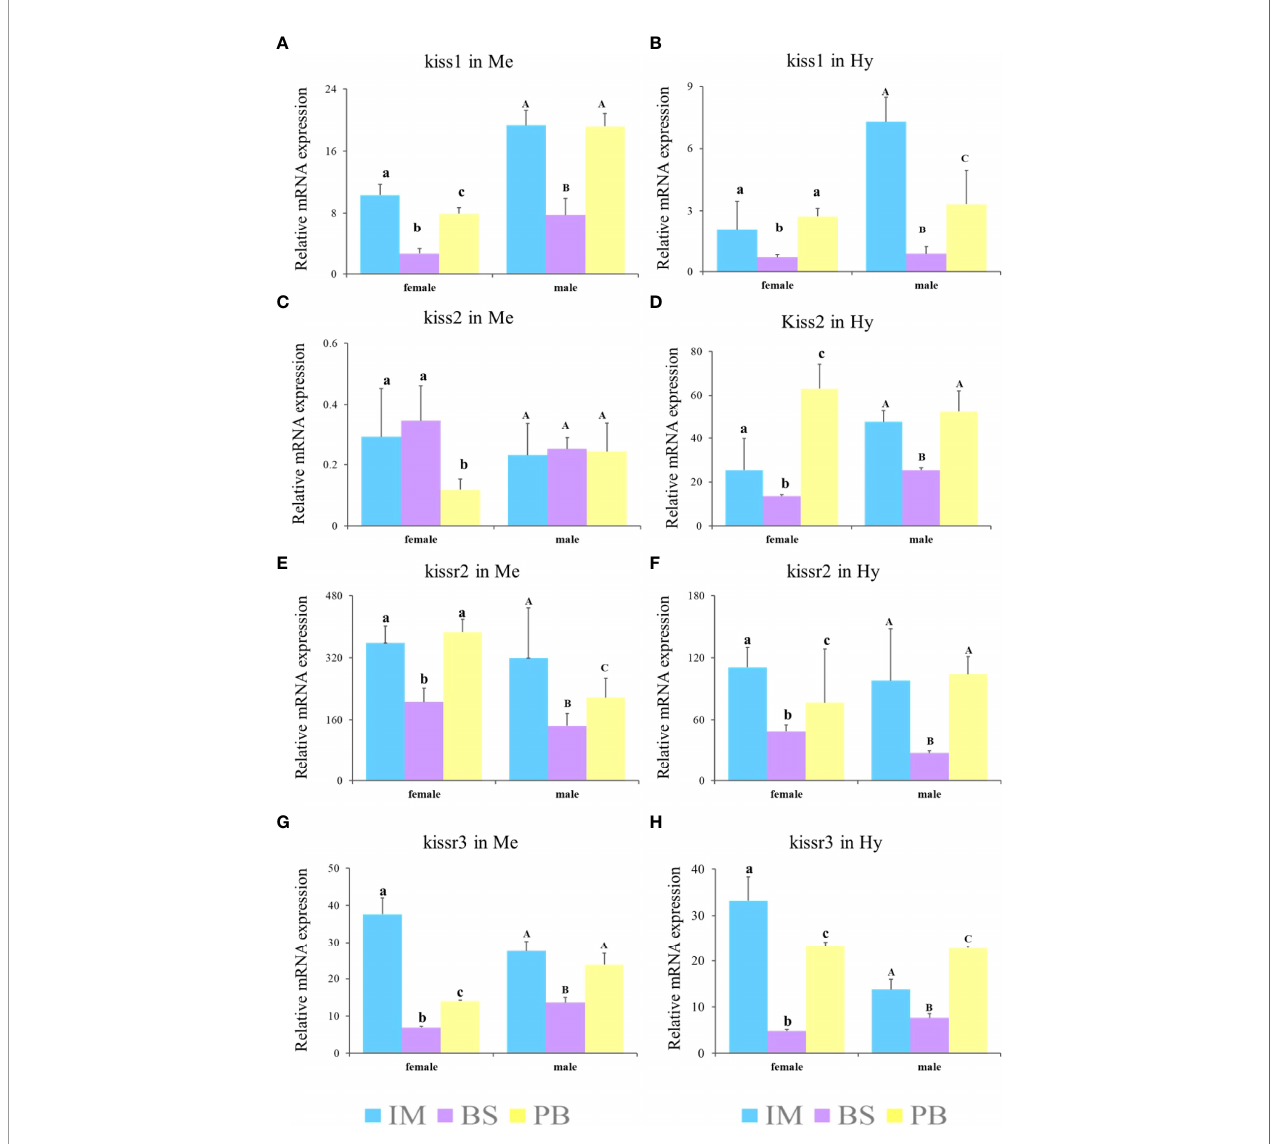
FIGURE 8 | Expression pro fi les of kiss/kissr genes in Me (A, C, E, G) and Hy (B, D, F, H) at immature stage (IM), the breeding season (BS) and post-breeding season (PB). Error bars are presented as the mean±SEM. The different lowercase letters in the fi gure represent statistical signi fi cance (p < 0.05) between two stages in female. The different uppercase letters in the fi gure represent statistical signi fi cance (p < 0.05) between two stages in